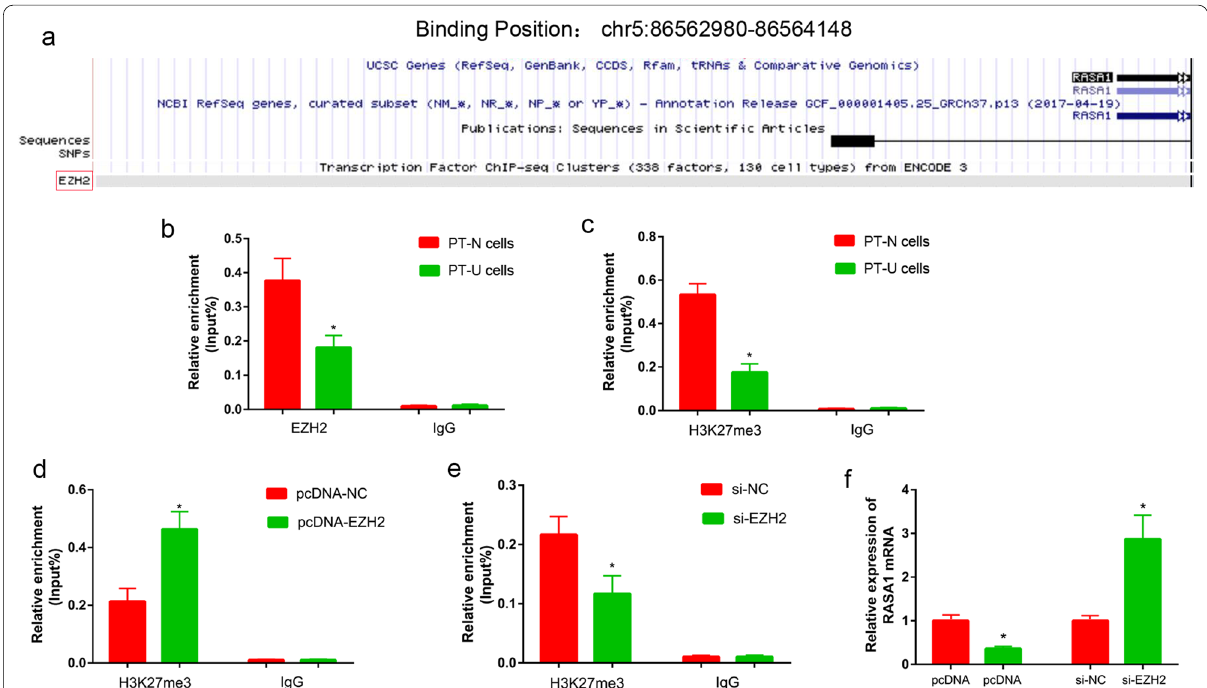
Fig. 4 EZH2 regulated RASA1 gene expression through histone methylation. a Bioinformatics analysis suggested presence of EZH2 protein binding site in RASA1 gene promoter. ChIP assay was used to detect the enrichment of EZH2 ( b ) and H3K27me3 ( c ) in RASA1 gene promoter of PT-U and PT-N cells. The enrichment of EZH2 in RASA1 gene promoter of pcDNA-EZH2 ( d ) and si-EZH2 ( e ) transfected PT-U cells. f The expression of RASA1 in pcDNA-EZH2 and si-EZH2 transfected PT-U cells was detected by